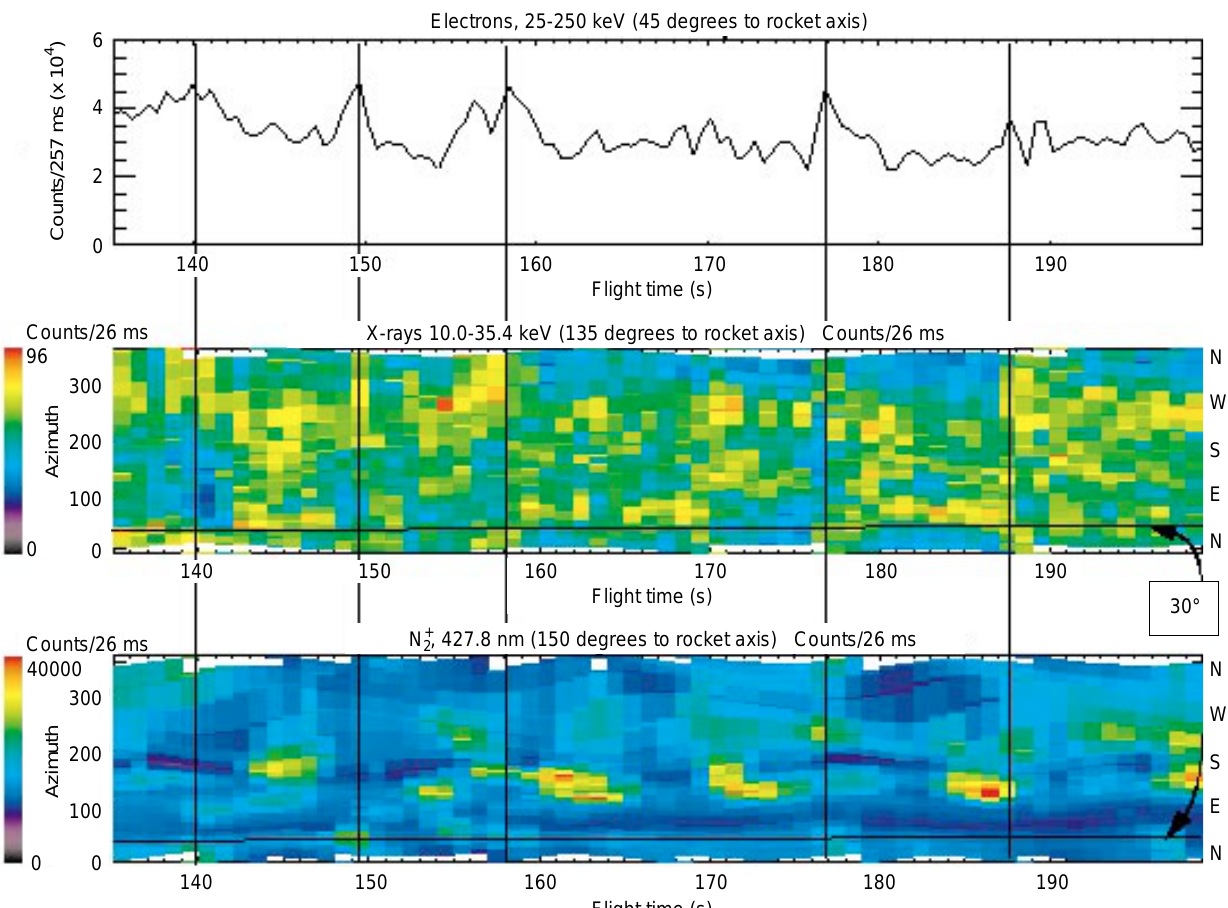
Fig. 4. Electrons (counts/257 ms): 25 < E e < 250keV, X-rays (counts/26 ms): 10 : 0 < E x < 35 : 4keV and N (cid:135) time-interval 135–199-s